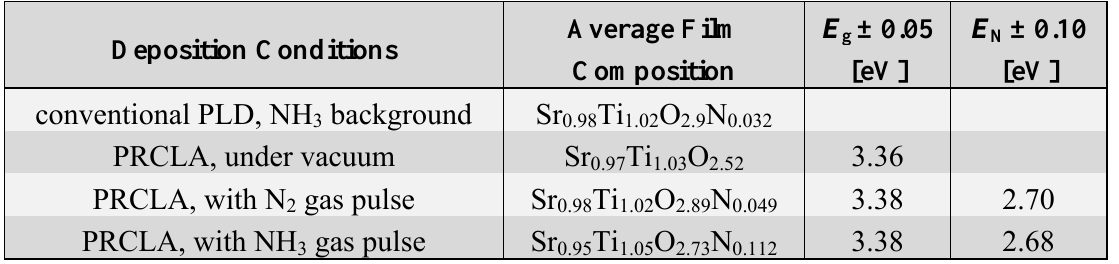
Table 1. Properties of the N-substituted SrTiO conditions at 650 °